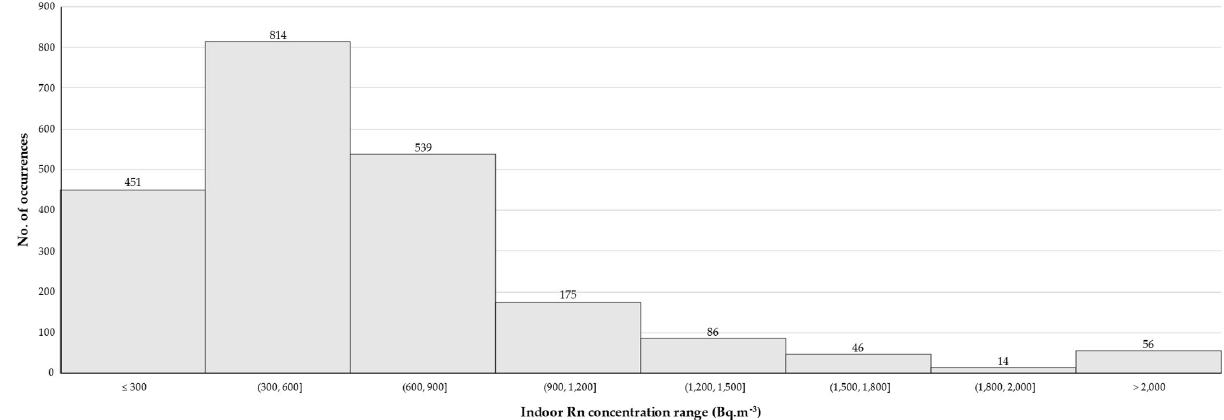
Figure 6. Distribution of measurements performed in the evaluation of the Rn concentration in the compartment after application of the barrier membrane.